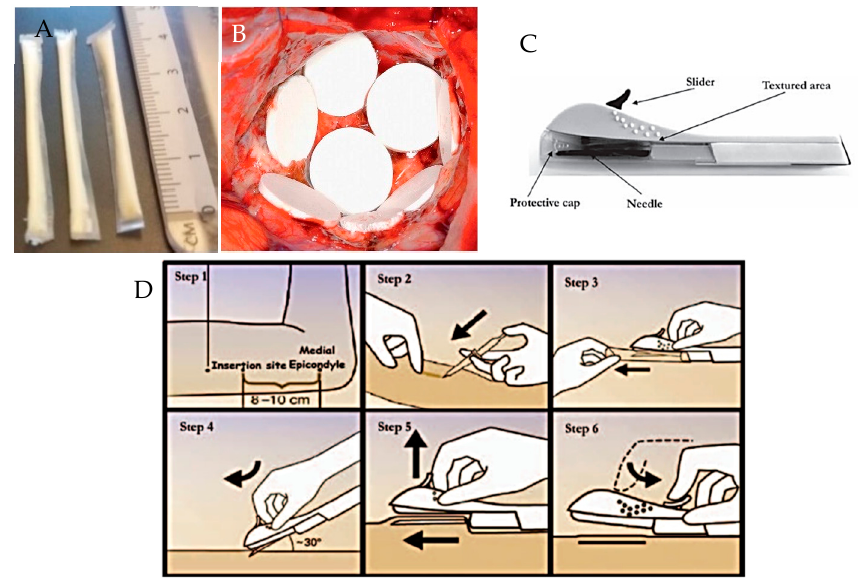
Figure 11. Images showing: ( A ) prototype PCL film implants [9]; ( B ) Gliadel Wafers ® , reproduced with permission from [114] ( C ) Nexplanon ® applicator device and ( D ) insertion of Nexplanon ® using its applicator device, reproduced with permission from [115].